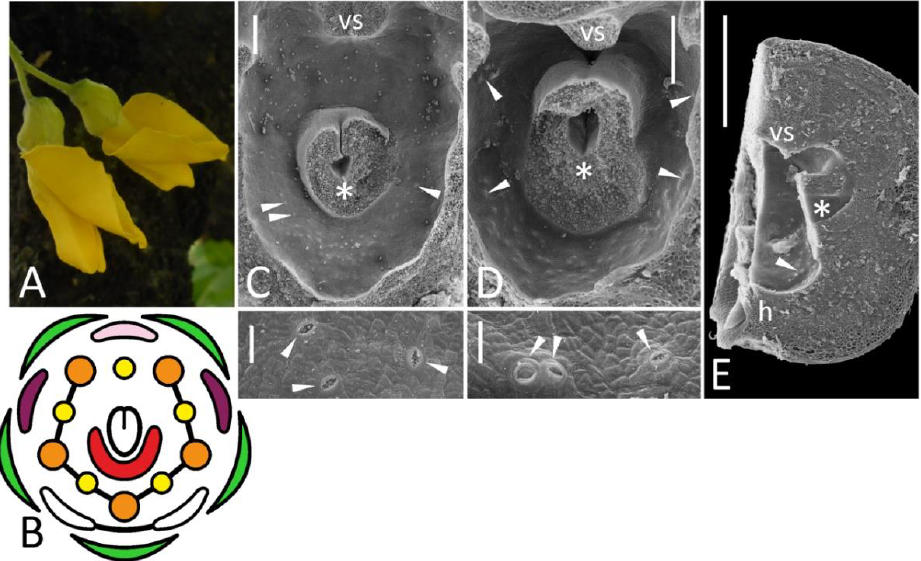
Figure 5. Floral morphology ( A , photo; B , diagram) and localization of FNs ( C – E , SEM images) in normal Caragana arborescens ( A – C ) and C. arborescens f. lorbergii : ( D ), top view, ( E ), longitudinal section. In ( C , D ), the upper part represents an overall view, while the lower part is a closer view of secretory area. All SEM images are oriented with an abaxial side downwards. Key: arrowheads = exemplary nectariferous stomata; asterisk = carpel base or place where it was attached; h = hypanthium; vs = vexillary stamen. For color designations on floral diagrams, see Figure 1. Scale bar: 1 mm ( E ), 300 μm (upper parts of C , D ), 30 μm (lower parts of C , D ).